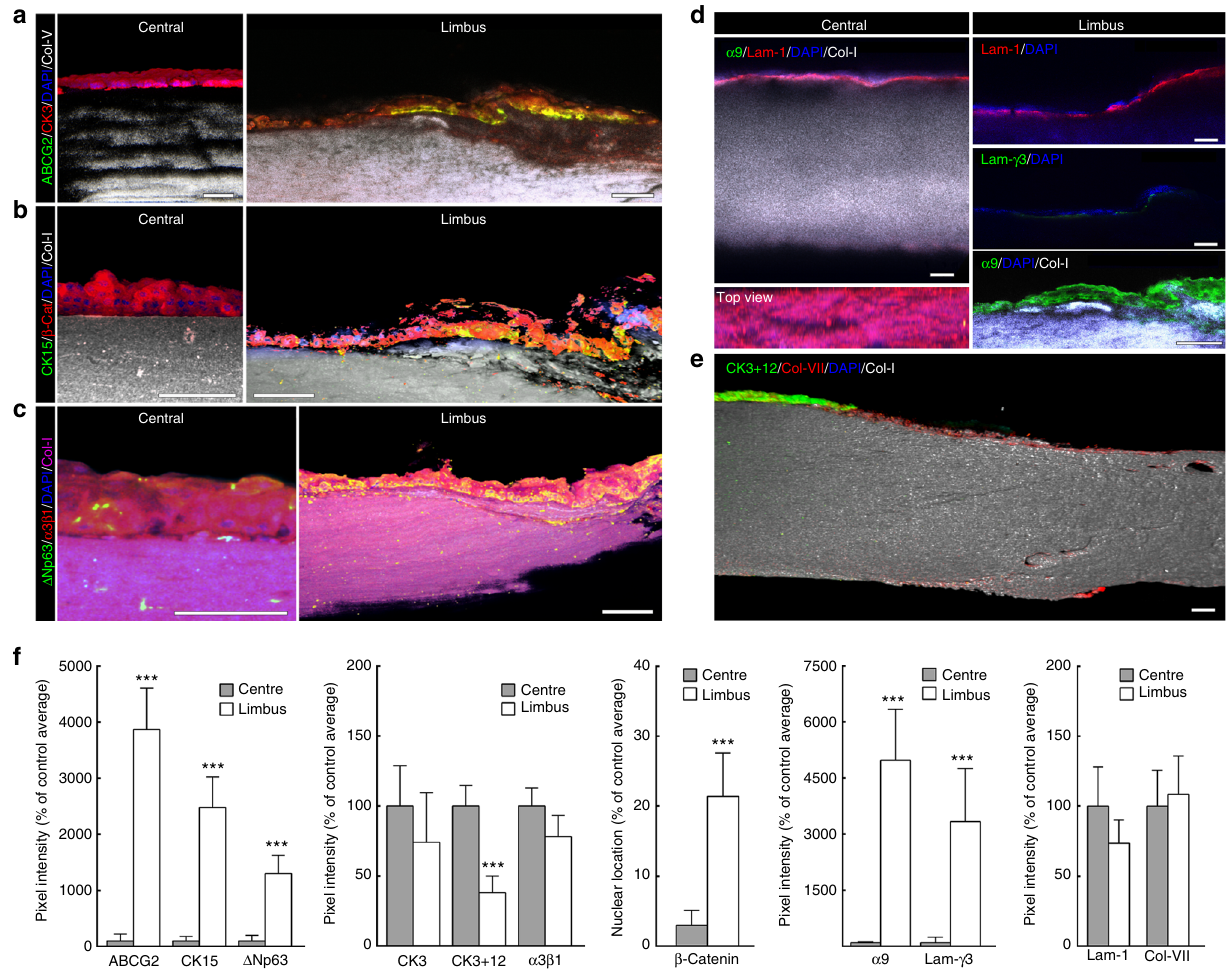
Fig. 2 LESC residency corresponds to limbal regions with distinctly softer mechanical properties. Representative confocal immuno fl uorescence micrographs of corneal epithelial cell markers and ECM components were used to reconstruct in 3D the limbus and central cornea. Expression of limbal markers ABCG2 ( a ), CK15 ( b ), and Δ Np63 ( c ), were expressed by limbal epithelial cells supported by collagen-I-positive/collagen-V-negative matrix, but not by central corneal epithelium ( a – c ). Markers such as CK3 ( a ), β -catenin ( b ), and integrin- α 3 β 1 ( c ) showed higher expression in the central corneal epithelium. Histochemical distinction between central cornea and limbus was further evidenced by the basement membrane markers and corresponding receptors. The limbus showed a discontinuous distribution of laminin-1 compared to the central cornea, and the speci fi c expression of laminin- γ 3 and integrin- α 9 ( d ). Conversely, the central corneal epithelium was positive for CK3 + 12 and collagen-VII ( e ). Cell nuclei were detected using DAPI. f Marker expression was quanti fi ed and represented as average ± S.D. from all three independent experiments ( n = 3; *** corresponds to p < 0.001 after one-way ANOVA). Source data are provided as a Source Data fi le. Scale bars, 100 µ